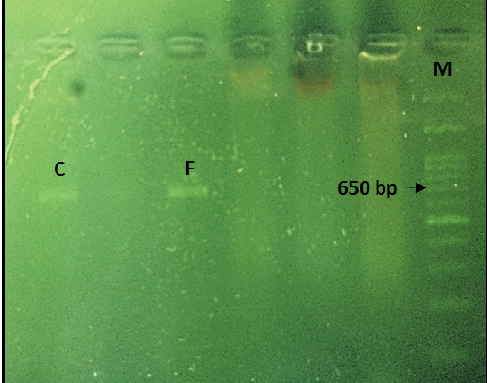
F IGURE 1. PCR-amplified COI genes of C. coronatus and C. frigidus visualized on a 1% agarose gel (M: DNA marker; C: C. coronatus , F: C. frigidus